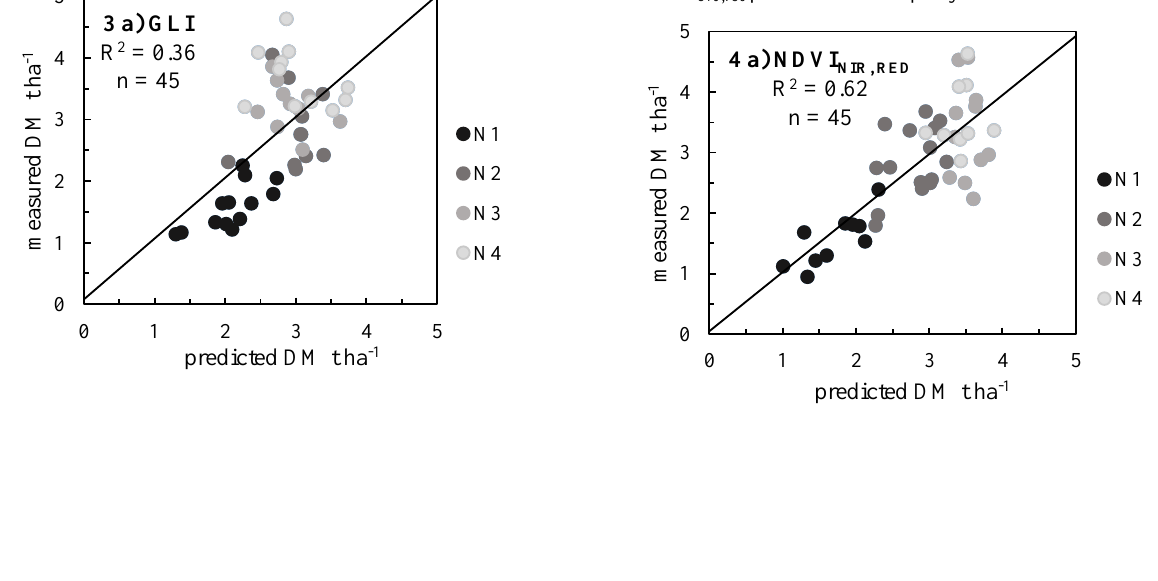
Table 3. Regression models of the validation dataset. P < 0.005 from the N-Sensor measurements. The optimized narrowband NDVI 800,750 performs best with an R 2 of 0.65. The NDVI NIR,RED and the SR 810,750 perform almost equally